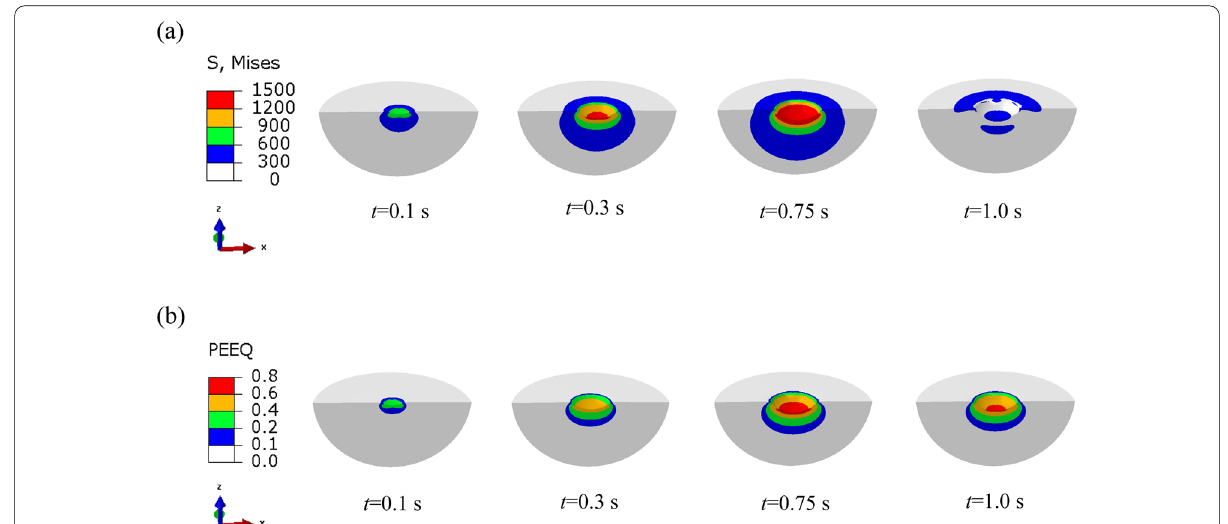
Figure 16 (a) Mises stress of indentation process under 10% elongation, (b) equivalent plastic strain (PEEQ) of indentation process under 10%